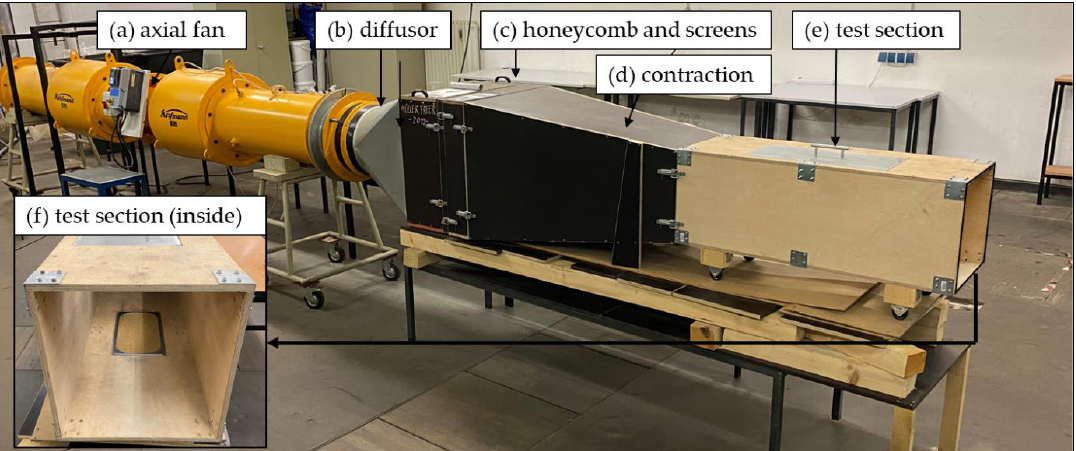
Figure 2. Wind tunnel and wind tunnel test section, showing individual components ( a – f ). Adapted from Freer et al. [15,16].